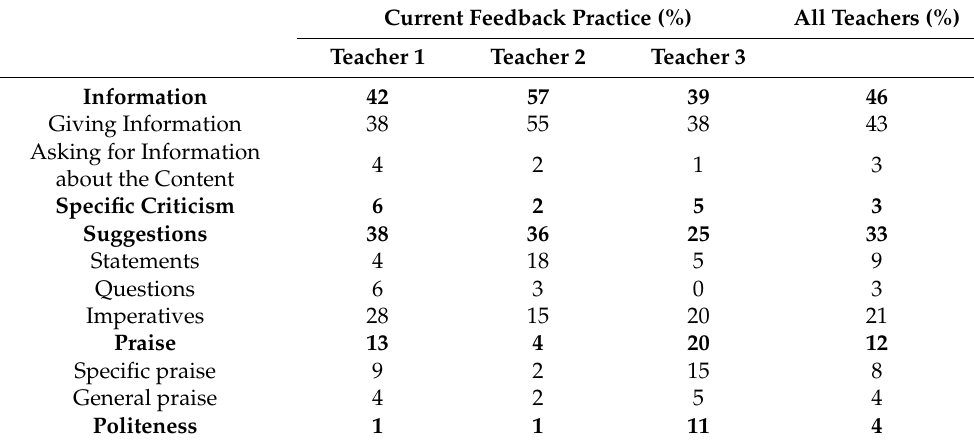
Table 2. Feedback of the manner for all three